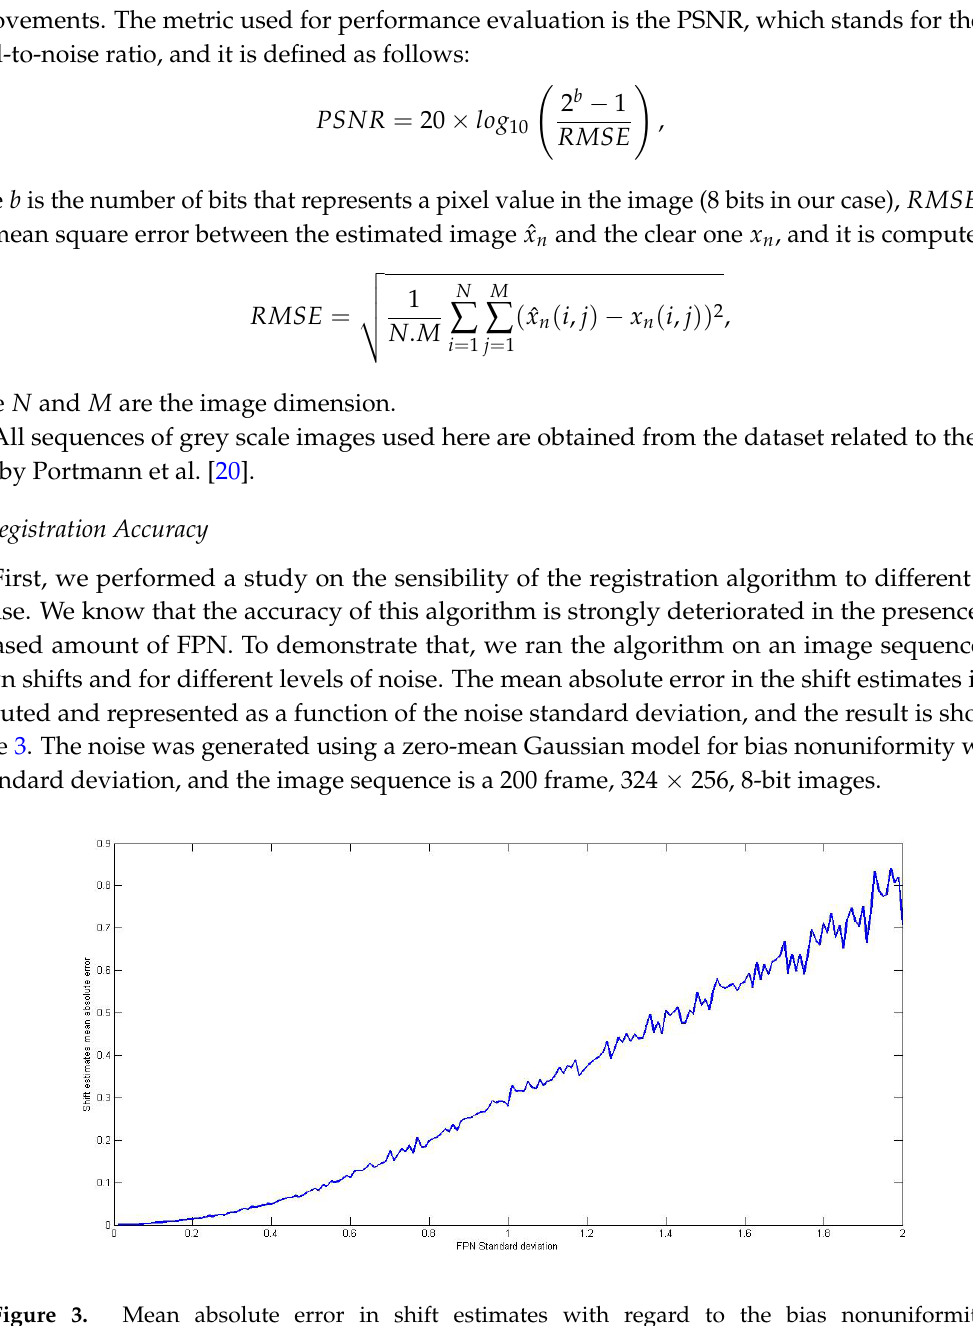
Figure 3. Mean absolute error in shift estimates with regard to the bias nonuniformity standard